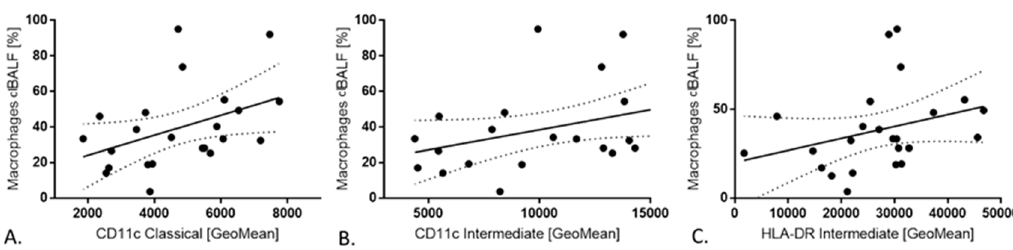
Figure 4. The correlations between monocytes in peripheral blood PB and macrophages in bronchoalveolar lavage fluid from cancer affected lung(clBALF). ( A ) Positive correlation between CD11c expression on classical monocytes in PB and macrophages in clBALF. ( B ) Positive correlation between CD11c expression on intermediate monocytes in PB and macrophages in clBALF. ( C ) Positive correlation between HLA-DR expression on intermediate monocytes in PB and macrophages in